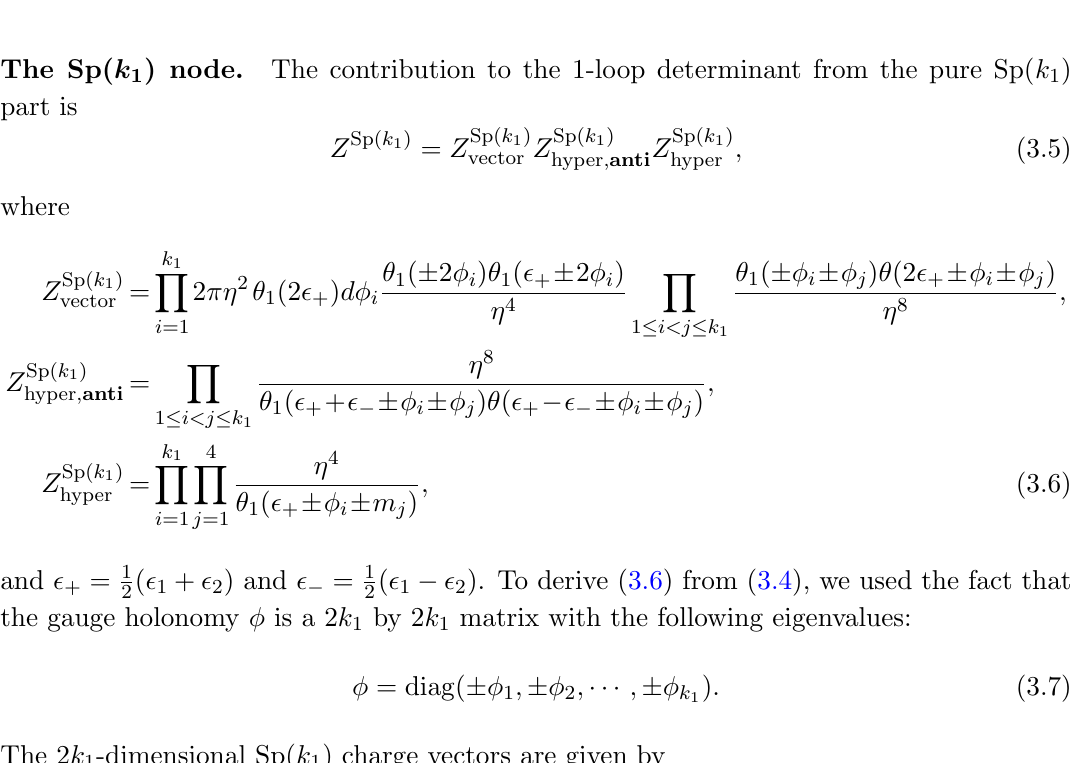
Table 1 . The (cid:12)eld contents of D 4